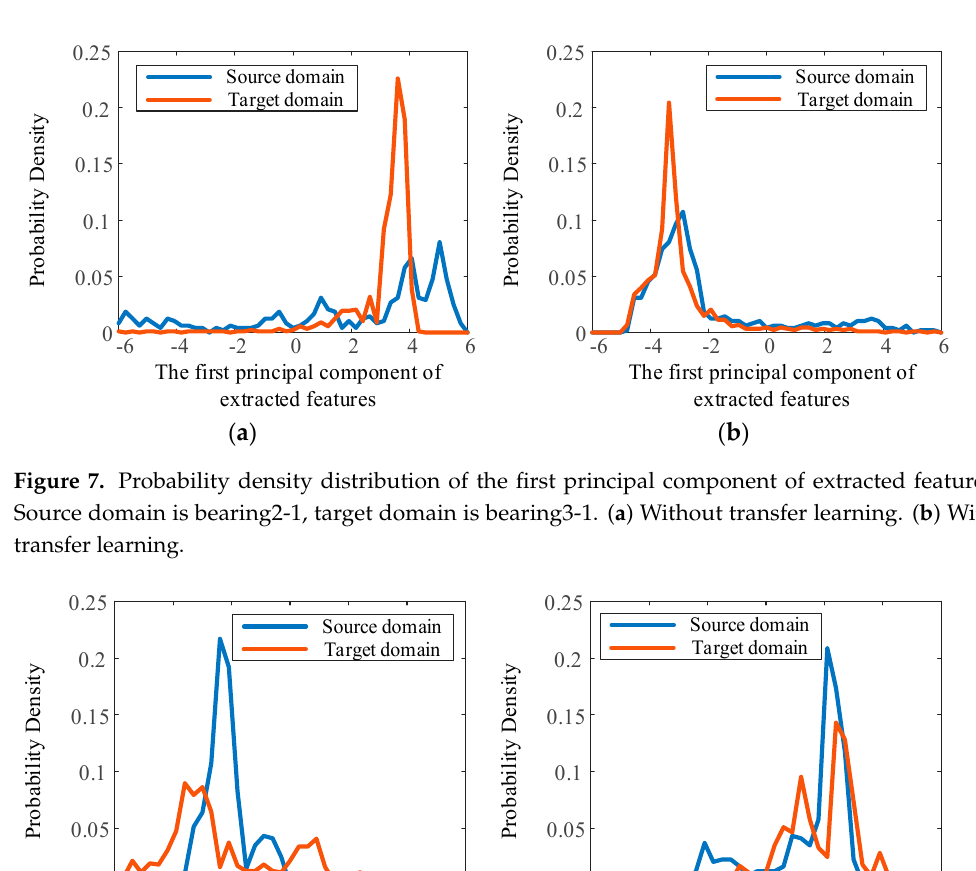
Table 4. RMSE prediction results under different noise levels.